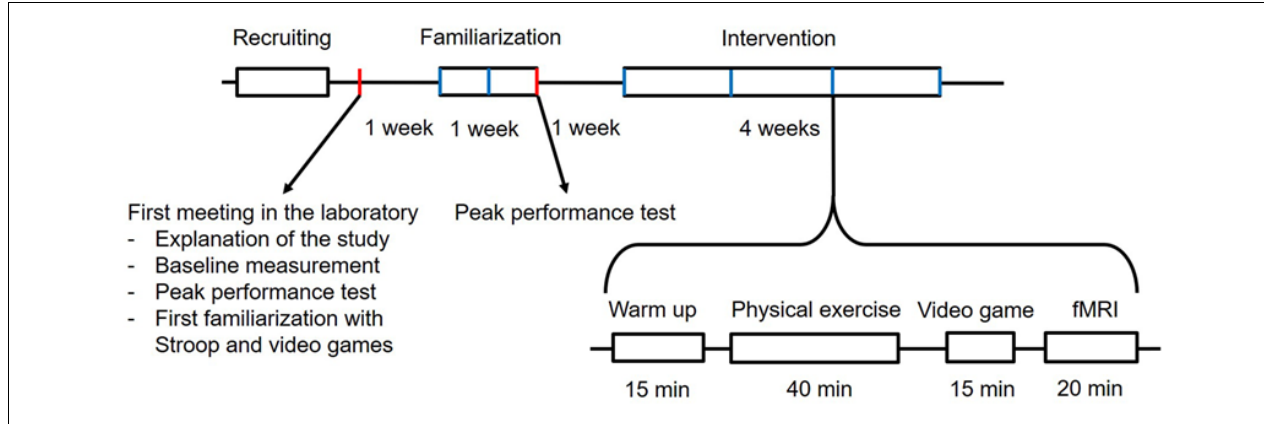
FIGURE 2 | Timelines and phases of this